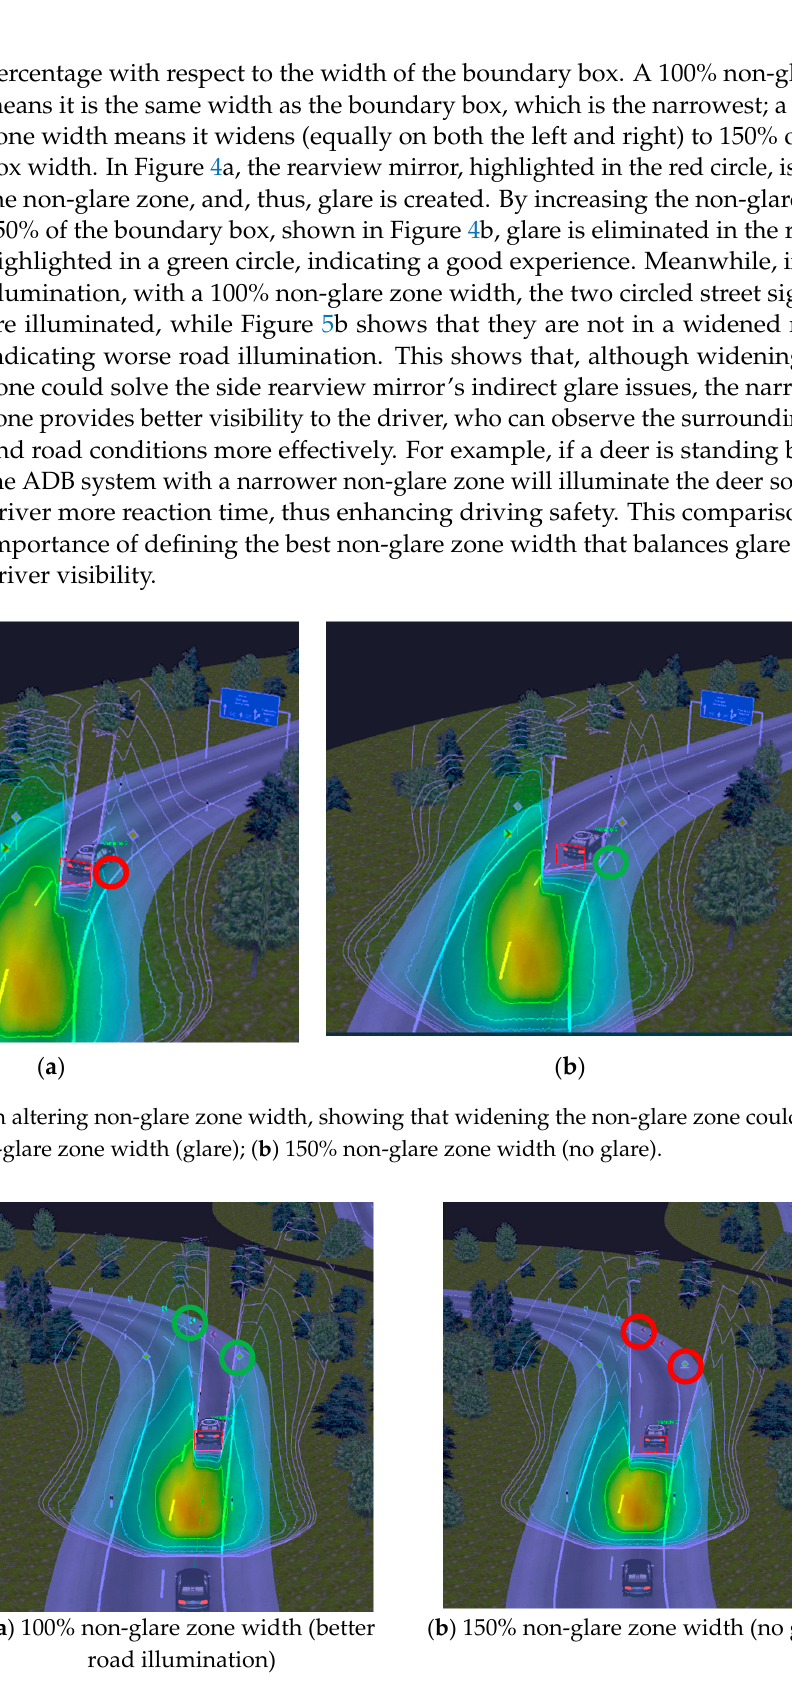
zone is highlighted with yellow dashed lines showing that, with the modification, the side rearview mirror will be ex- cluded from the boundary box during the cornering maneuver. The comparison shows that the simulator’s modified AFS plug-in can reproduce the glare issue.